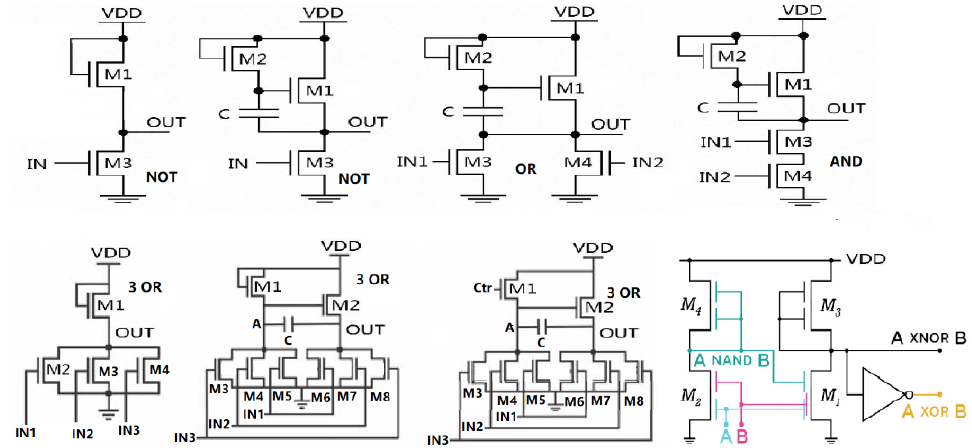
Figure 16. Basic logic circuit with oxide TFTs [163,164] (Reprinted with permission from ref. [164]. Copyright 2022 IOP Publishing).